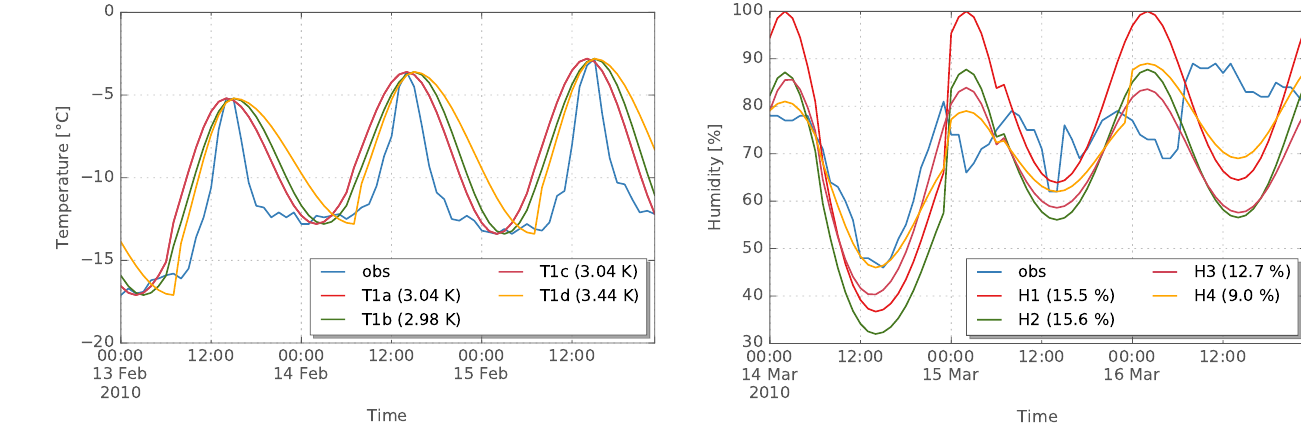
Figure 4. Example application of different humidity disaggregation models for Obergurgl. Observed and disaggregated time series are shown for relative humidity. The numbers in parentheses indicate the root mean square error (RMSE) computed for each